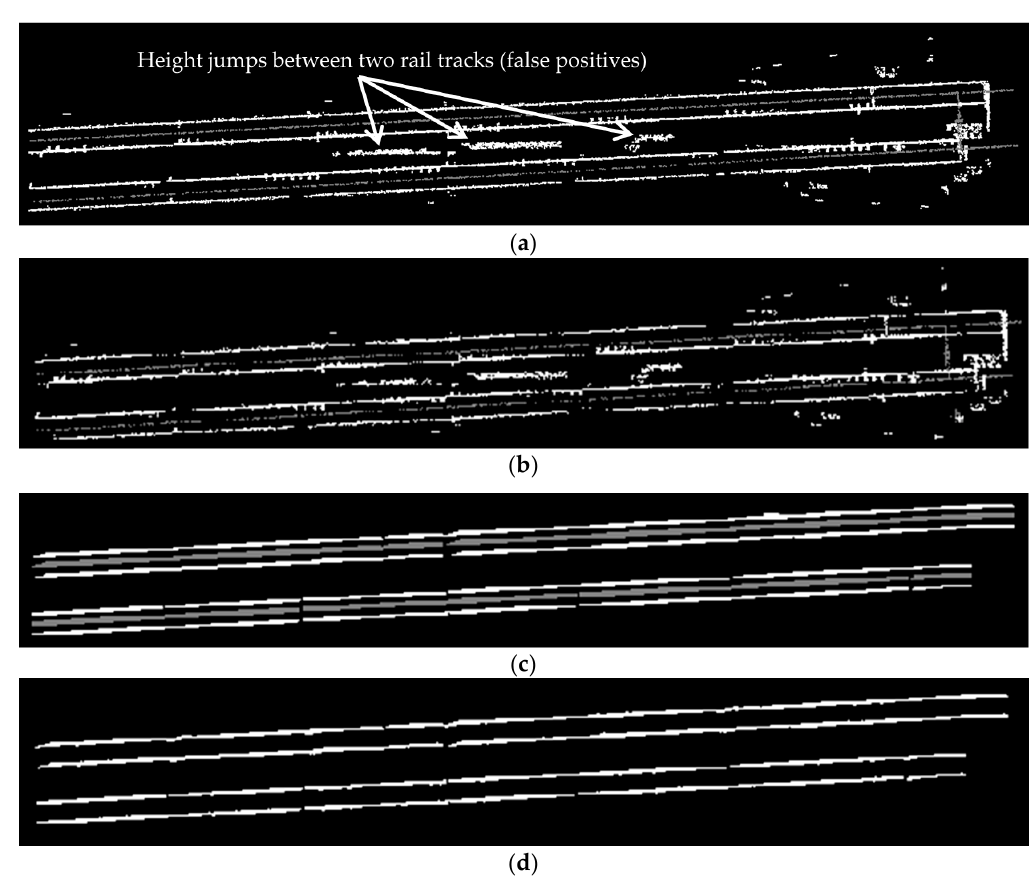
Figure 12. The intermediate and final results of the employed template matching method: ( a ) The point cloud of the height jump detection results in which height jumps and points of class 2 are indicated in white and grey color, respectively; ( b ) The grey scale image of the height jump results; ( c ) The template matching results in which the false positives in the rail track classification results are excluded; ( d ) The template matching final result that shows only the rail tracks.